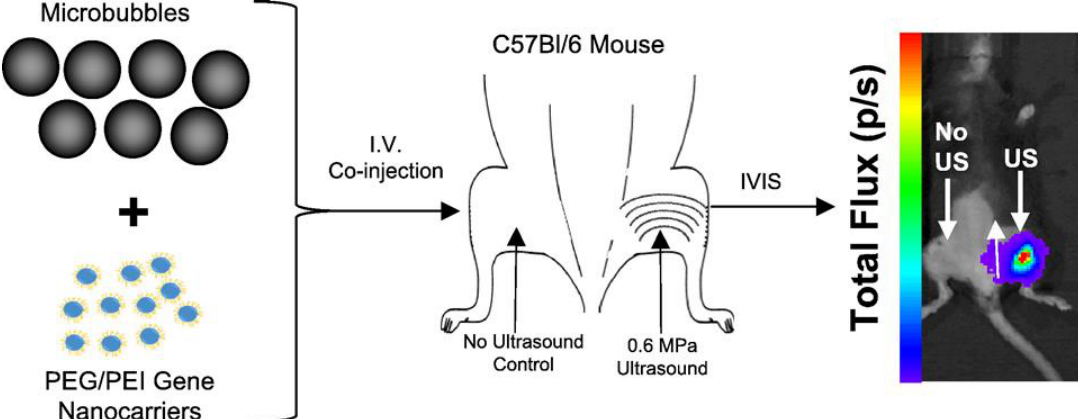
Figure 3. Overview of the strategy for eliciting ultrasound-targeted transfection of hindlimb adductor muscles via the delivery of non-viral gene nanocarriers. ( Left ) Contrast agent microbubbles are intravenously co-injected with gene-bearing nanocarriers. ( Middle ) Pulsed ultrasound is then applied to the adductor muscle group, which activates microbubble oscillation and facilitates nanocarrier delivery to the muscle tissue. ( Right ) Reporter gene expression is evident only where ultrasound has been applied. Adapted from Burke et al. [70].